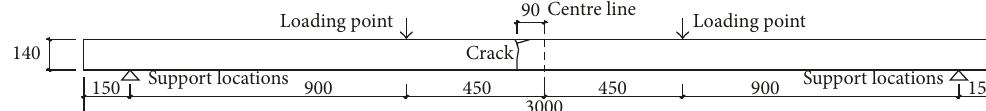
Figure 21: Crack location (mm).